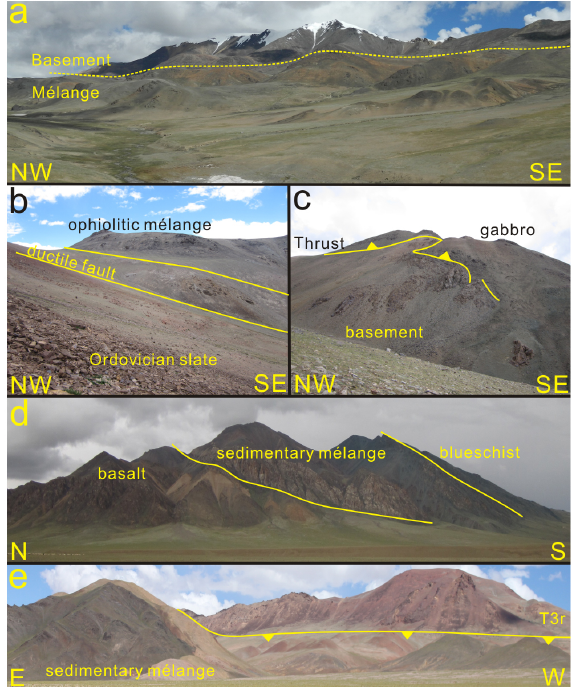
Figure 6. Field relationships of the main units. (a) View to the NW towards the Mayigang Ri Thrust, which thrusted basement on top of sedimentary mélange. (b) West of Rongma, ophiolitic mélange is thrusted on top of basement and Ordovician sediments, now sep- arated by a wide fault zone. (c) Folded thrust that placed gabbros of the ophiolitic mélange on top the basement, north of Gangtang Co. (d) View from the north towards Jiaomu Ri, clearly showing that blueschists lie above the sedimentary mélange, which in turn overlies basalts of the ophiolitic mélange. (e) North-dipping thrust places subduction mélange over Late Triassic limestone (T 3 r) in the south of the study area, showing that at least part of the thrusting postdated the Late